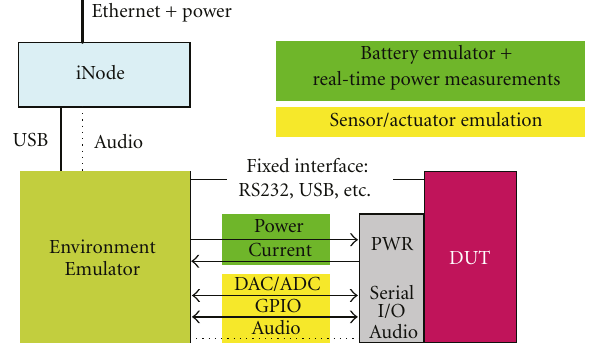
Figure 5: Features of the environment emulator. We have used the battery emulator and the real-time power measurements for our energy harvesting emulation.